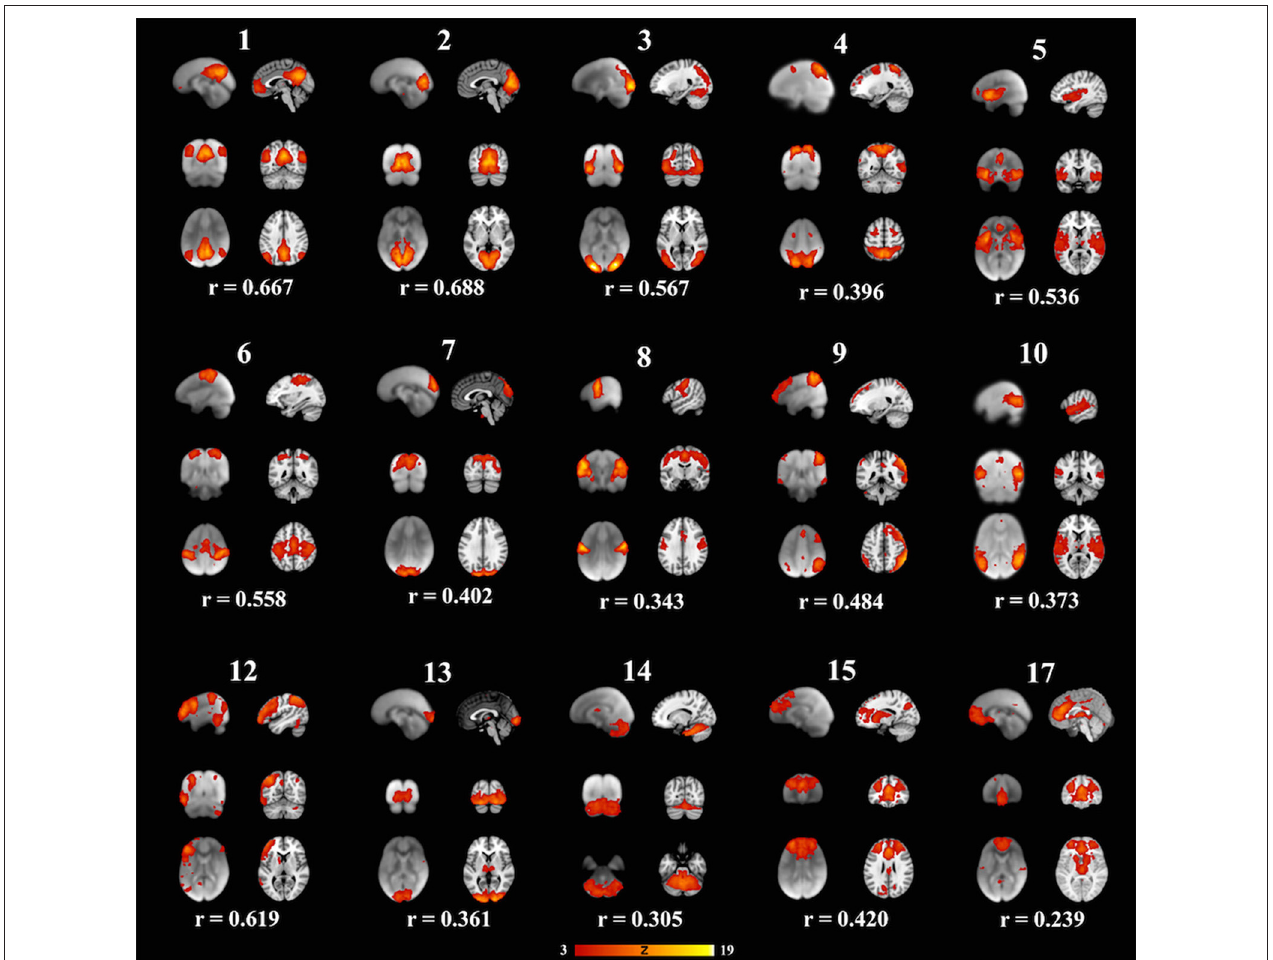
FIGURE 2 | Fifteen well-matched resting state networks from the 20-dimensional component analysis to the 20-dimensional study of a healthy adult population, as described elsewhere (Smith et al., 2009). Each individual component is shown with three informative orthogonal slices with the corresponding adult network slices at the given MNI152 standard space coordinates. The left column represents resting state networks in 6-7-year-old children overlaid on the group’s averaged anatomical brain. The right column represents the closest adult network overlaid on the adult MNI brain atlas. The networks demonstrated spatial cross-correlation coefficient (r) > 0.204, which based off methods outlined in Smith et al. (2009) relates to P < 0.0001. All overlays were made from the z-statistical images and thresholded to 3 < Z < 19. The coronal and axial images are shown in neurological convention, with the left side of the brain is represented in the left side of the